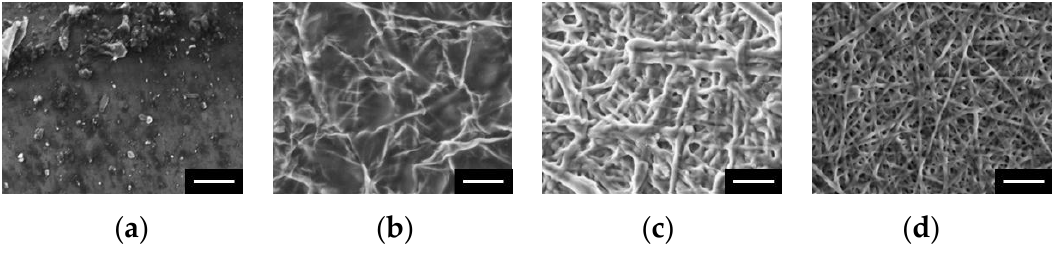
Figure 6. SEM images of PSA nanofibers after immersing in water. The nanofibers were prepared by adding ethylene glycol at concentrations of ( a ) 0 wt%; ( b ) 0.16 wt%; ( c ) 1.6 wt%; ( d ) 16 wt% (scale bar: 10 μm).